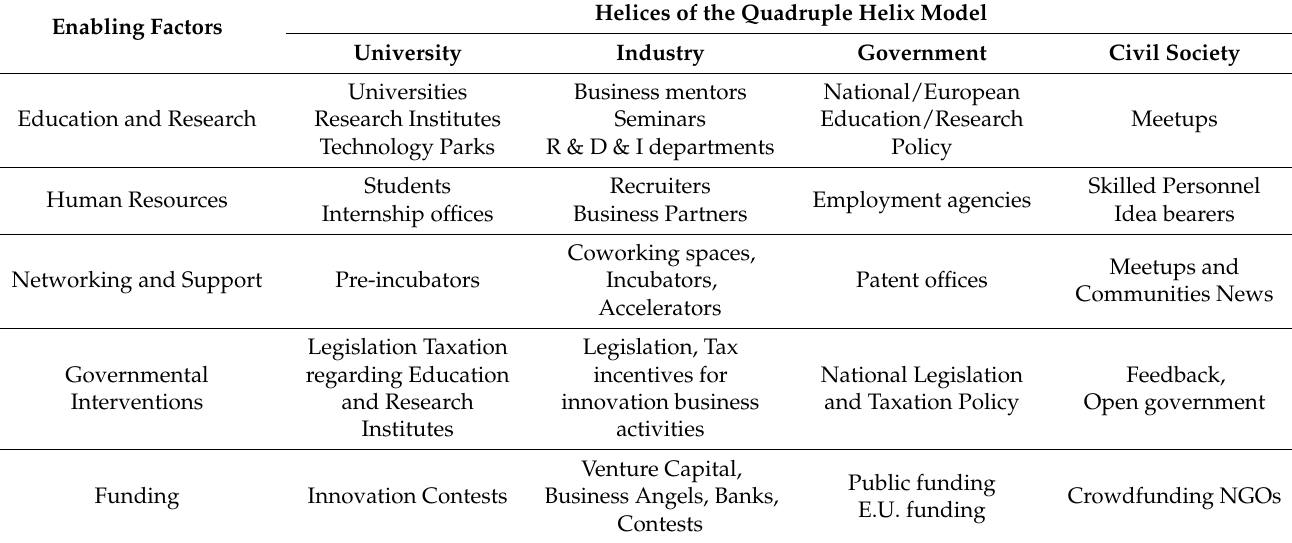
Table 1. Facilitators of a start-up ecosystem in